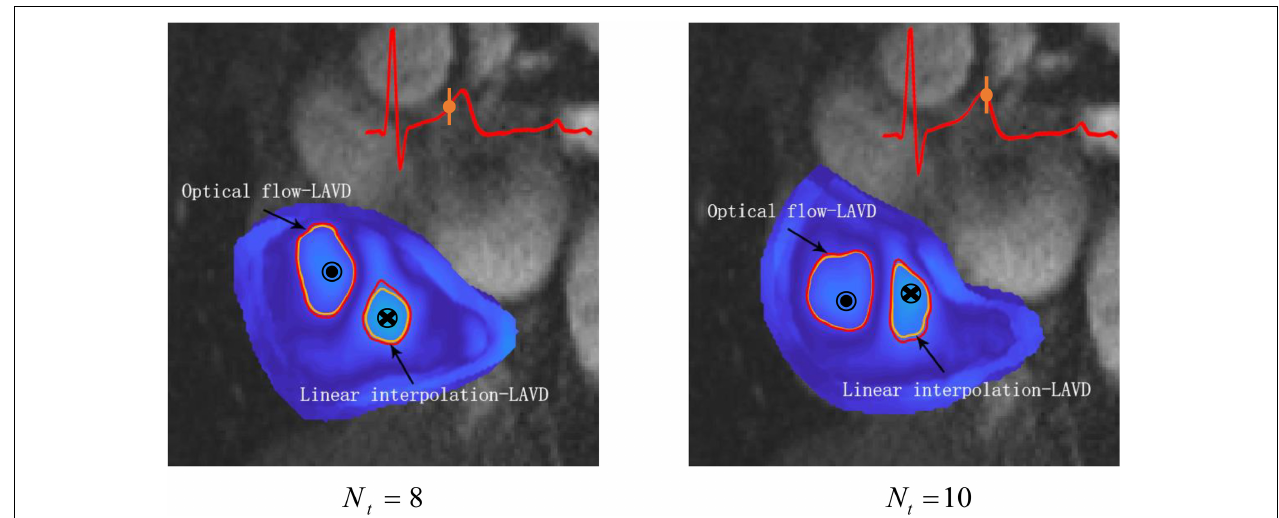
FIGURE 5 | The identification results of Lagrangian vortex rings based on Optical flow-LAVD (red) and linear interpolation-LAVD (orange).